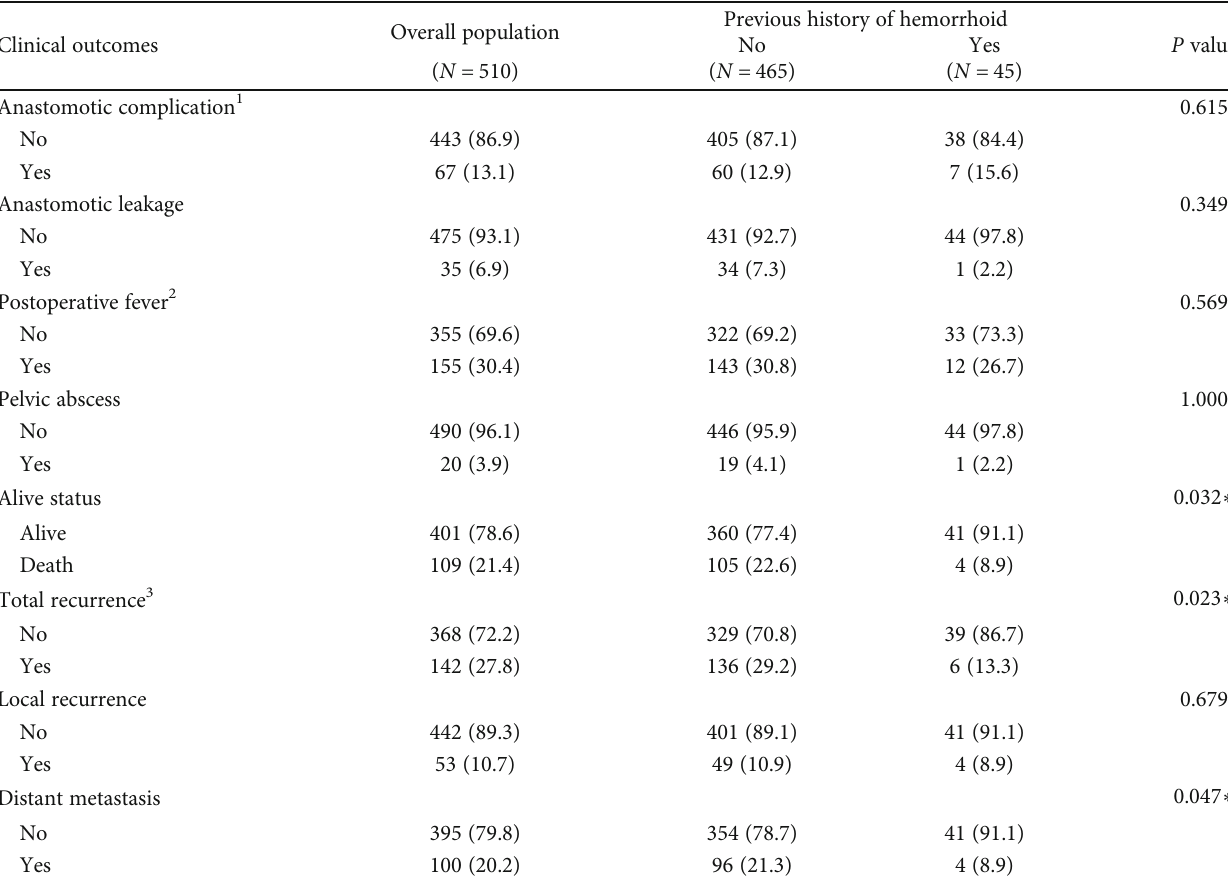
Table 2: Short-term and long-term outcomes after curative resection in patients with and without previous history of hemorrhoid. Clinical